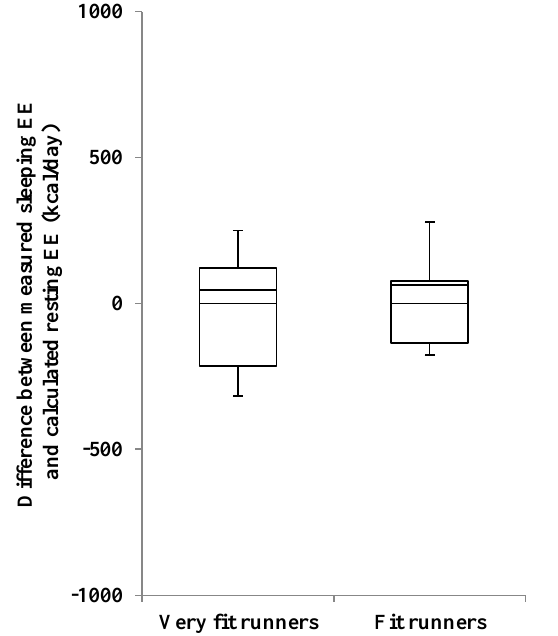
Figure 1. Box-plot diagram for comparing measured sleeping energy expenditure and estimated resting energy expenditure. EE: energy expenditure; REE: resting energy expenditure.